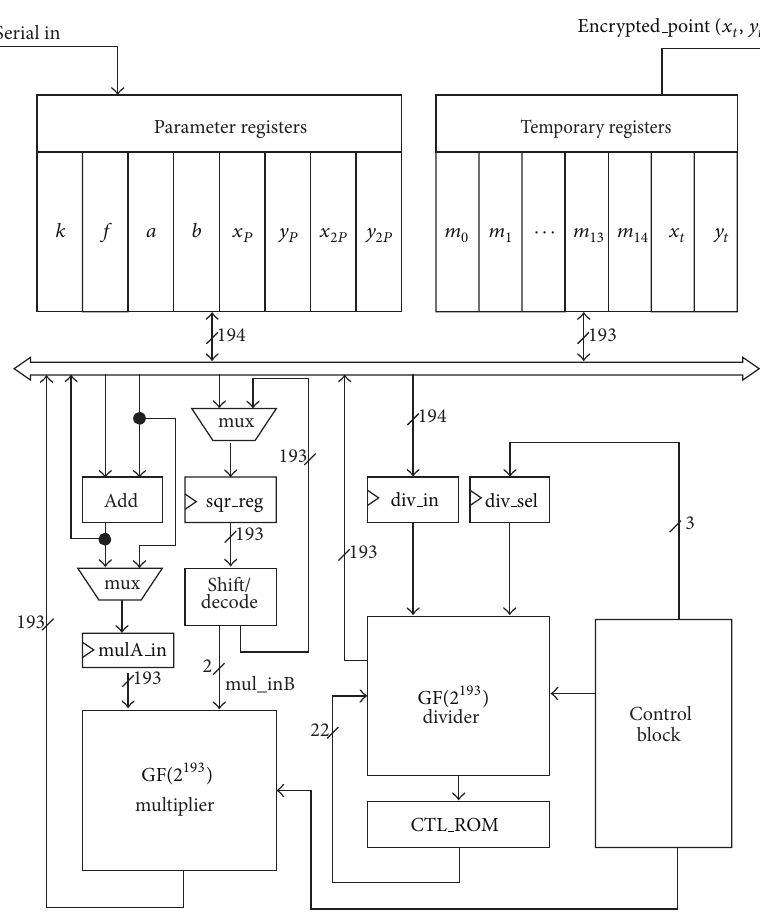
Figure 4: 193-Bit elliptic curve cryptography encryption processor engine.